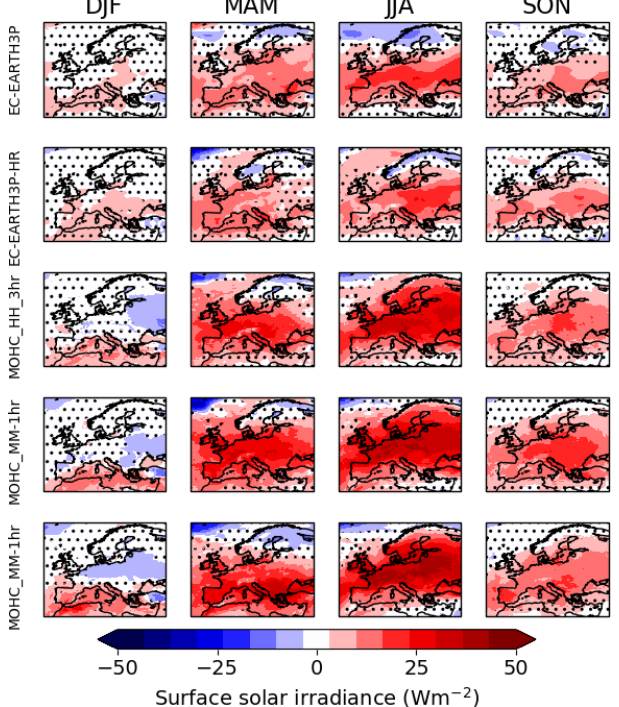
Figure 3. Seasonal-mean difference in surface solar irradiance be- tween 1980–2010 and 2020–2050 for the five different climate model simulations used in this study (see Table 1 for further de- tails of the models). Stippling shows grid points where no statis- tically significant climate change signal was found when using a two-sample t test (Wilks,